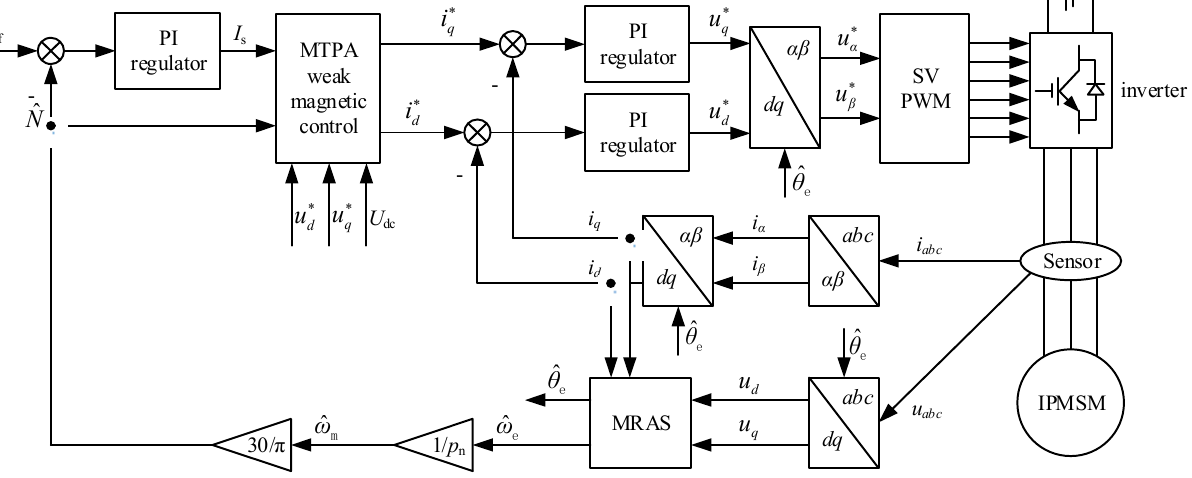
Figure 5. Block diagram of MRAS control system based on stator current.